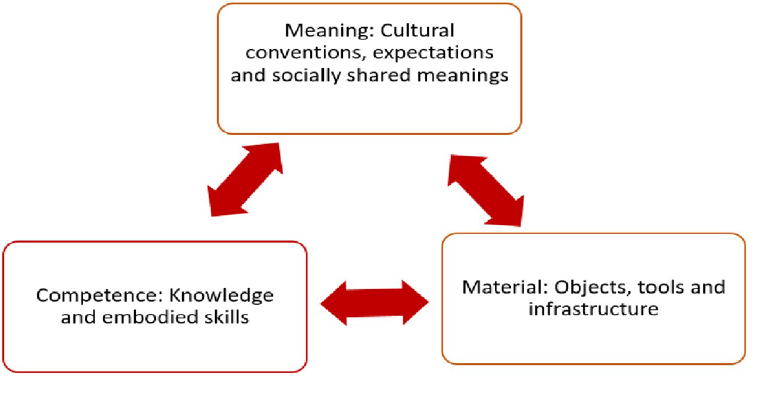
Fig 1. The social practice theory.